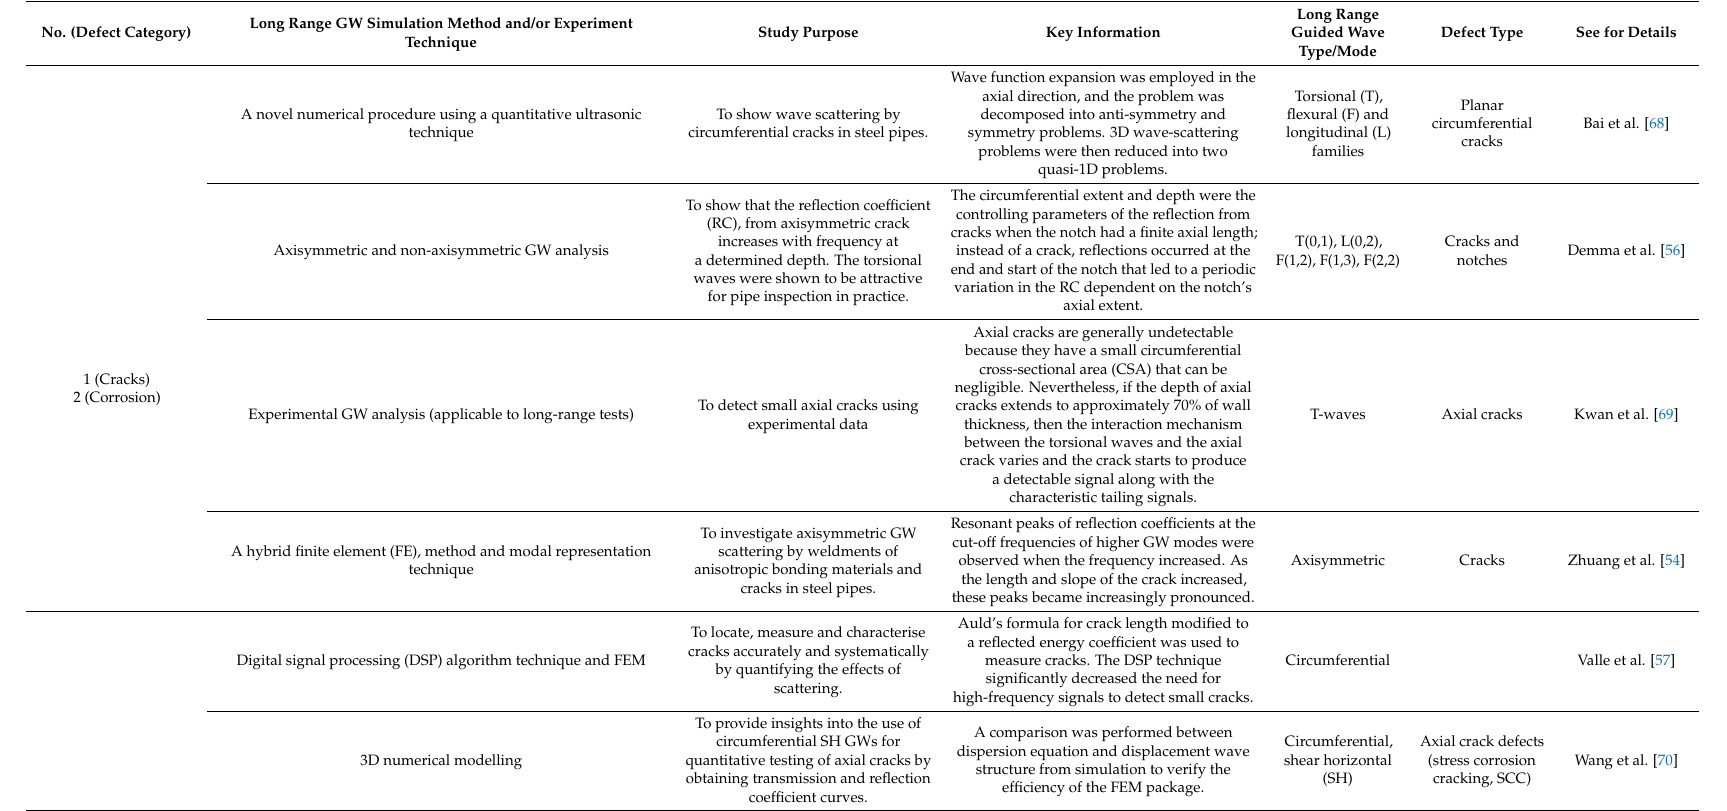
Table 1. Detection of defects in pipes using GWs